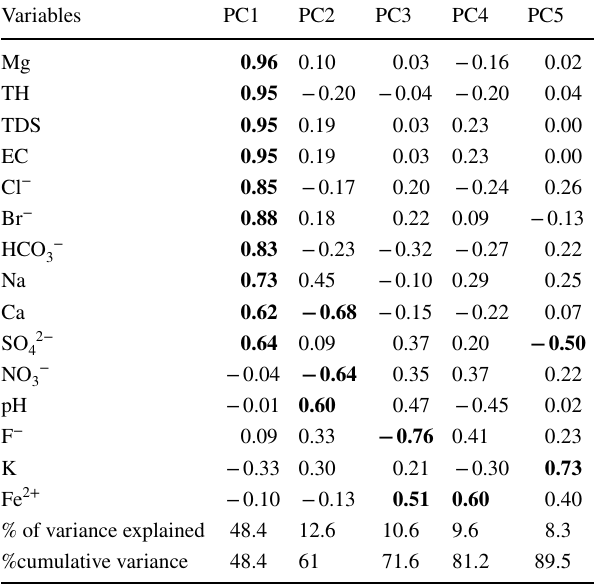
Table 4 Factor loadings for 15 hydrochemical parameters of ground- water